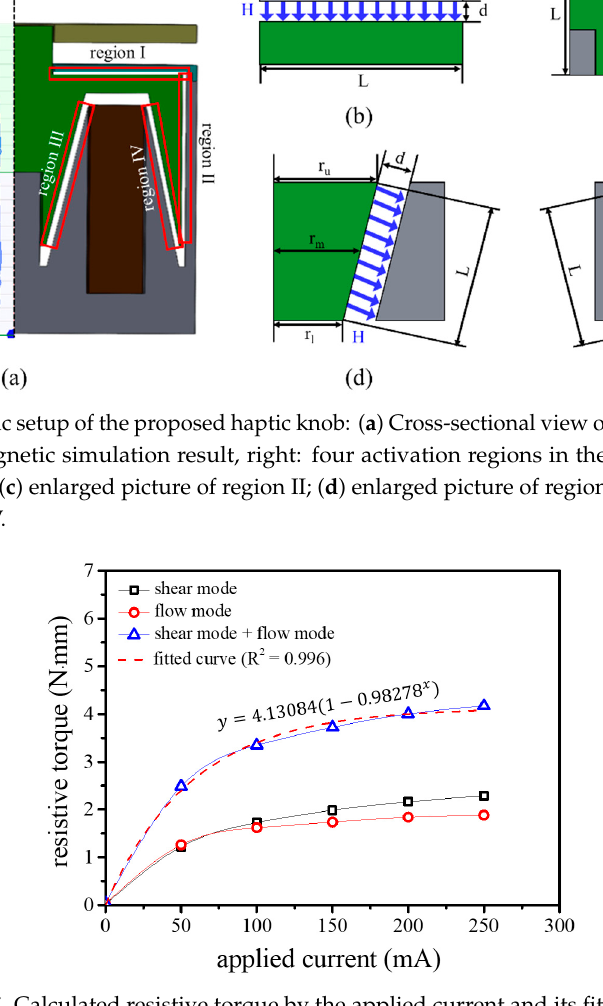
Figure 8. Components and prototype of the proposed actuator. 3. Results and Evaluation To measure the torque feedback from the proposed haptic knob, we constructed an experimental setup consisting of a personal computer (PC), a DC motor driver, a power supply, a control circuit, a load cell, a shaft arm, the proposed haptic knob, a coupler, and a DC motor, as shown in Figure 9. The dial plate of the proposed haptic knob was tightly connected to the DC motor using the coupler, and the shaft arm was connected to the proposed knob. As the DC motor started to rotate, the dial plate and rotary shaft also rotated together. The applied current caused MR fluids in the haptic knob to solidify and stop the DC motor. Torque feedback in the haptic knob was conveyed to the load cell through a shaft arm. The measured data by the load cell were multiplied by the length of the shaft arm ( r ) to compute the resistive torque. Finally, the computed resistive torque was saved to the PC.